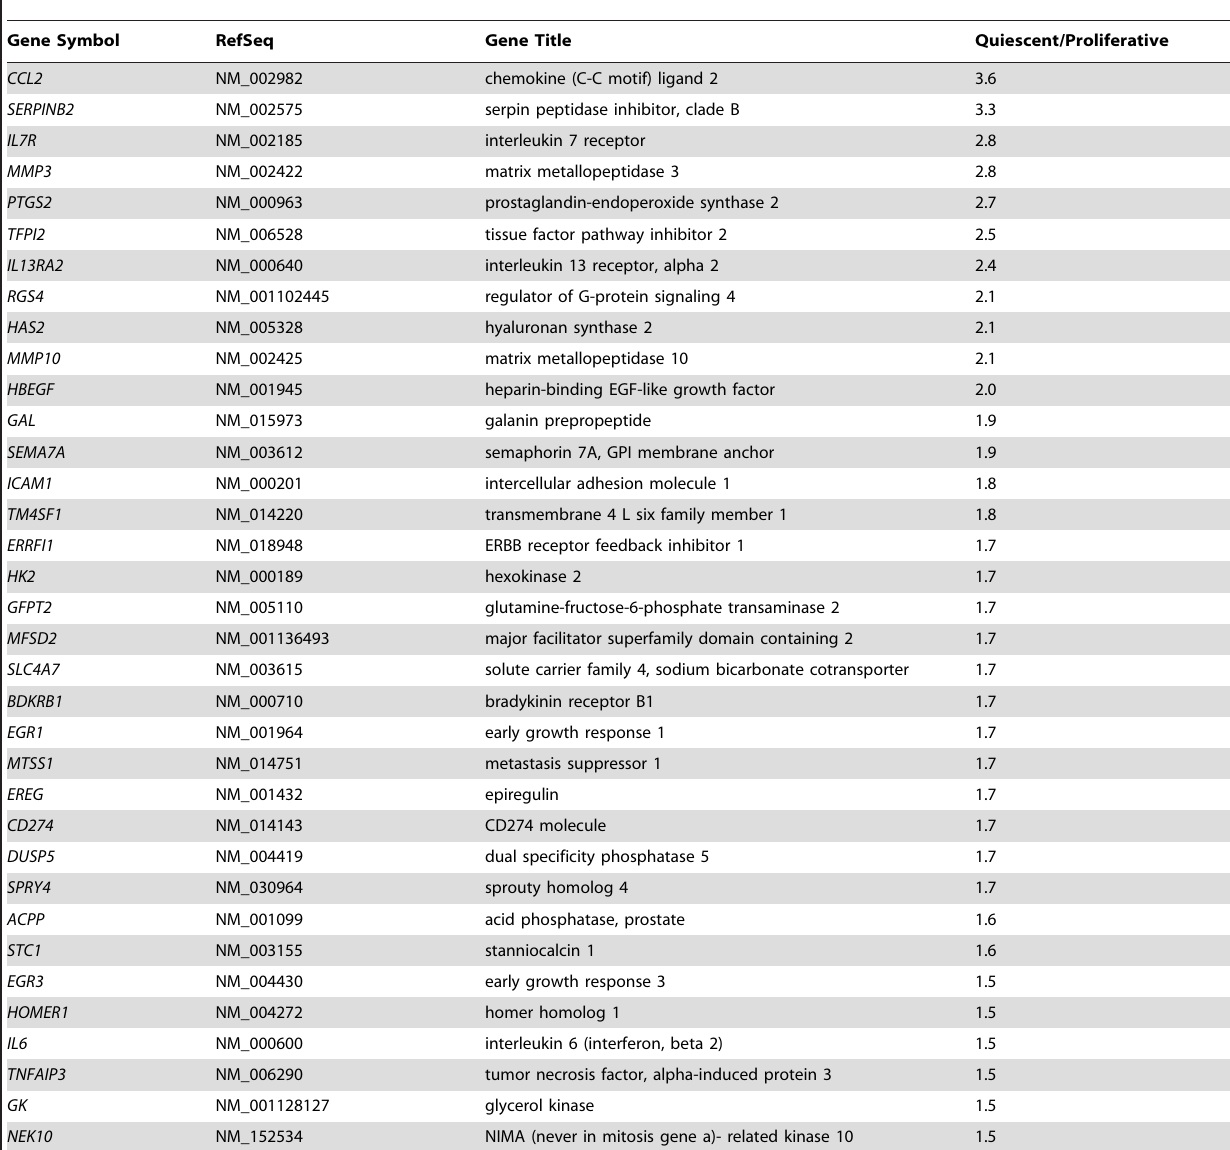
Table 1. List of genes with differential expression in quiescent vs. proliferative HsFb.